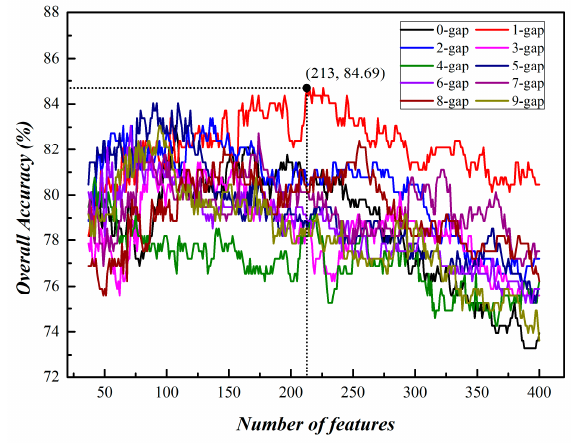
Figure 2. A plot showing the IFS curves for 0-gap to 9-gap.